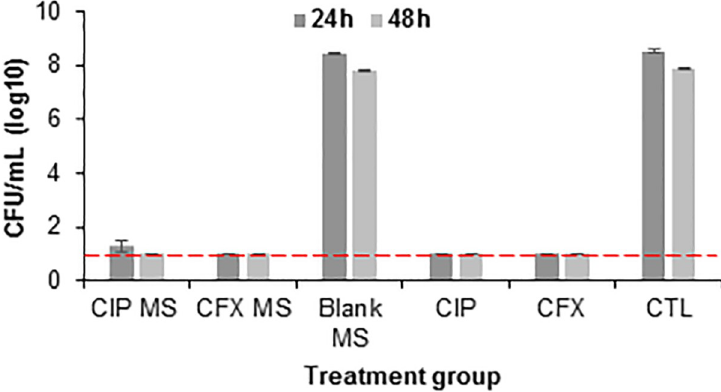
Fig 6. In vitro clearance of bacteria treated with antibiotics and microspheres (MS). Clearance of Haemophilus influenzae after 24-48h due to treatment with ciprofloxacin (CIP) MS, ceftriaxone (CFX) MS, blank MS, 1 μ g/mL CIP, 5 μ g/mL CFX, or no treatment control (CTL). MS treatment groups were applied in concentration of 10mg MS/mL bacterial culture. Error bars represent the average ± standard error for n = 8 samples for CIP MS and CFX MS groups and n = 4 samples for all other groups. Red dotted line indicates complete bacterial